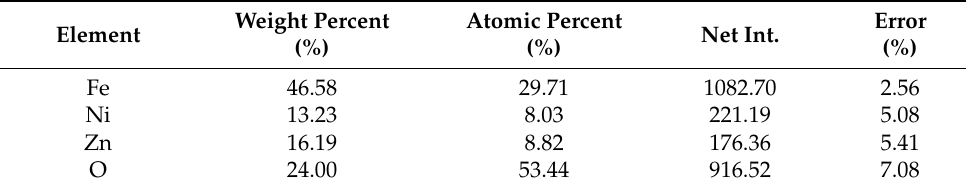
Figure 4. FE-SEM images of calcined NZF nanofibers obtained by electrospinning: ( a ) low magnifi- cation of the nanofibers, ( b ) high magnification of the nanofibers, ( c ) low magnification of the com- mercial nanoparticles, and ( d ) high magnification of the commercial nanoparticles. Table 2. EDX spectrum analysis results for calcined NZF nanofibers. Table 2. EDX spectrum analysis results for calcined NZF